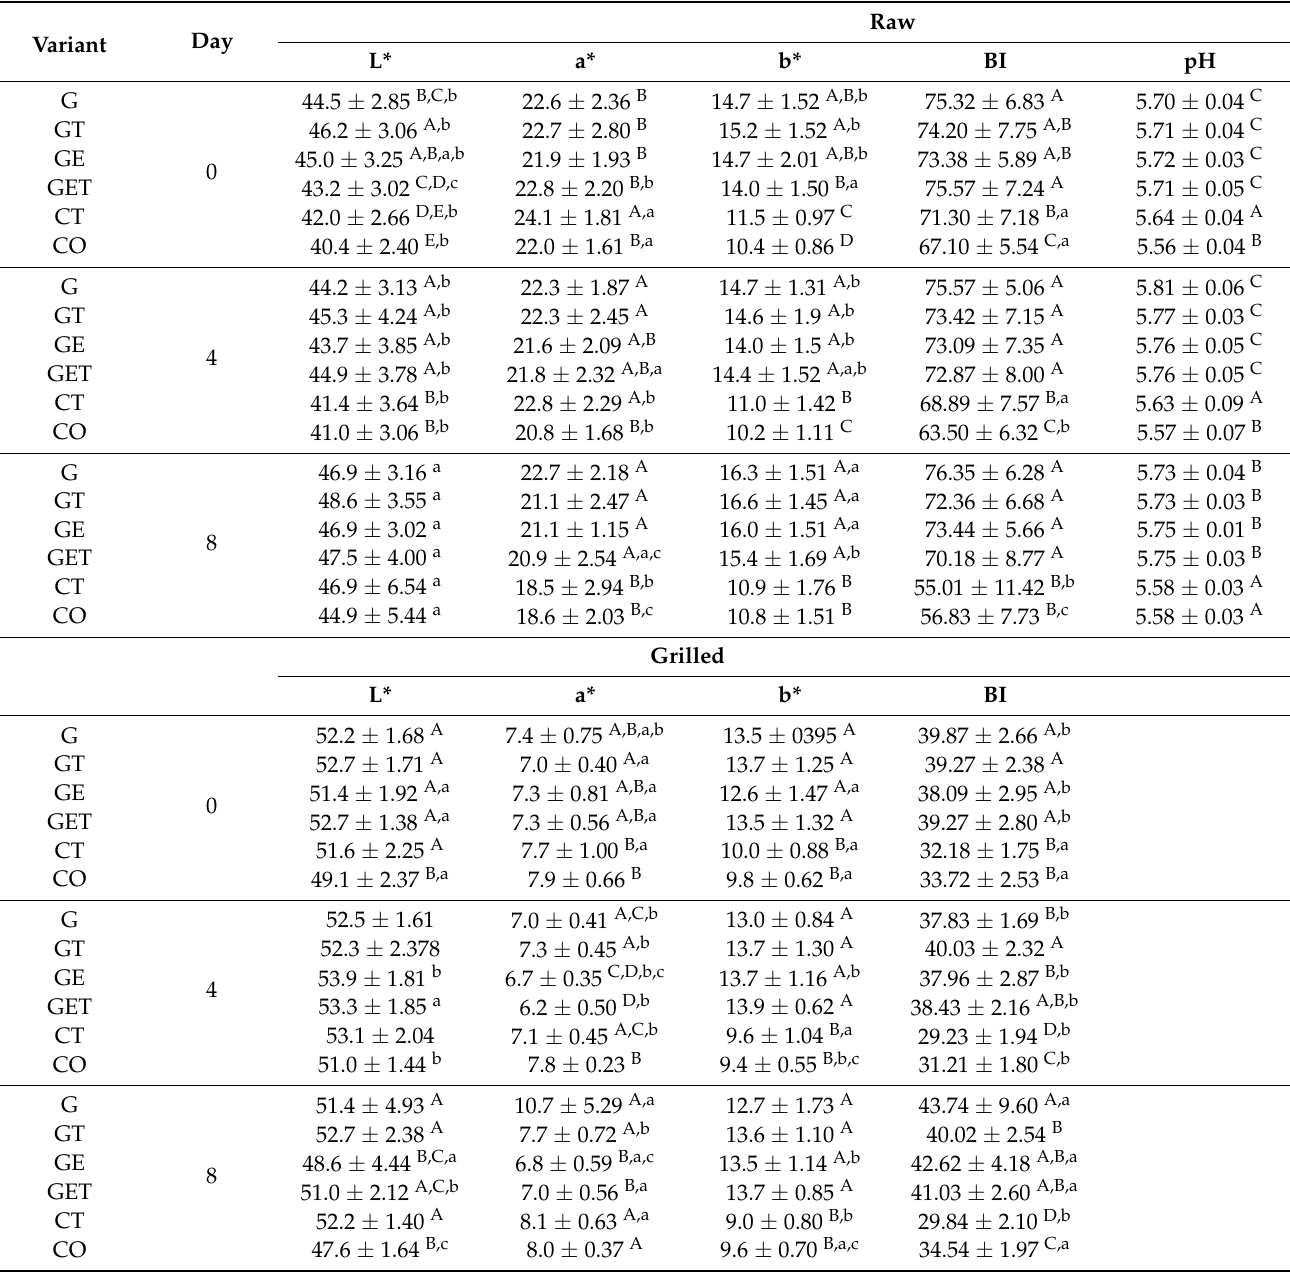
Table 4. Effect of fat substitute in the form of a hydrogel with encapsulated safflower oil, açai extract, and linseed flour on color parameters, browning index (BI), and pH in raw and grilled burgers at 0, 4, and 8 days of